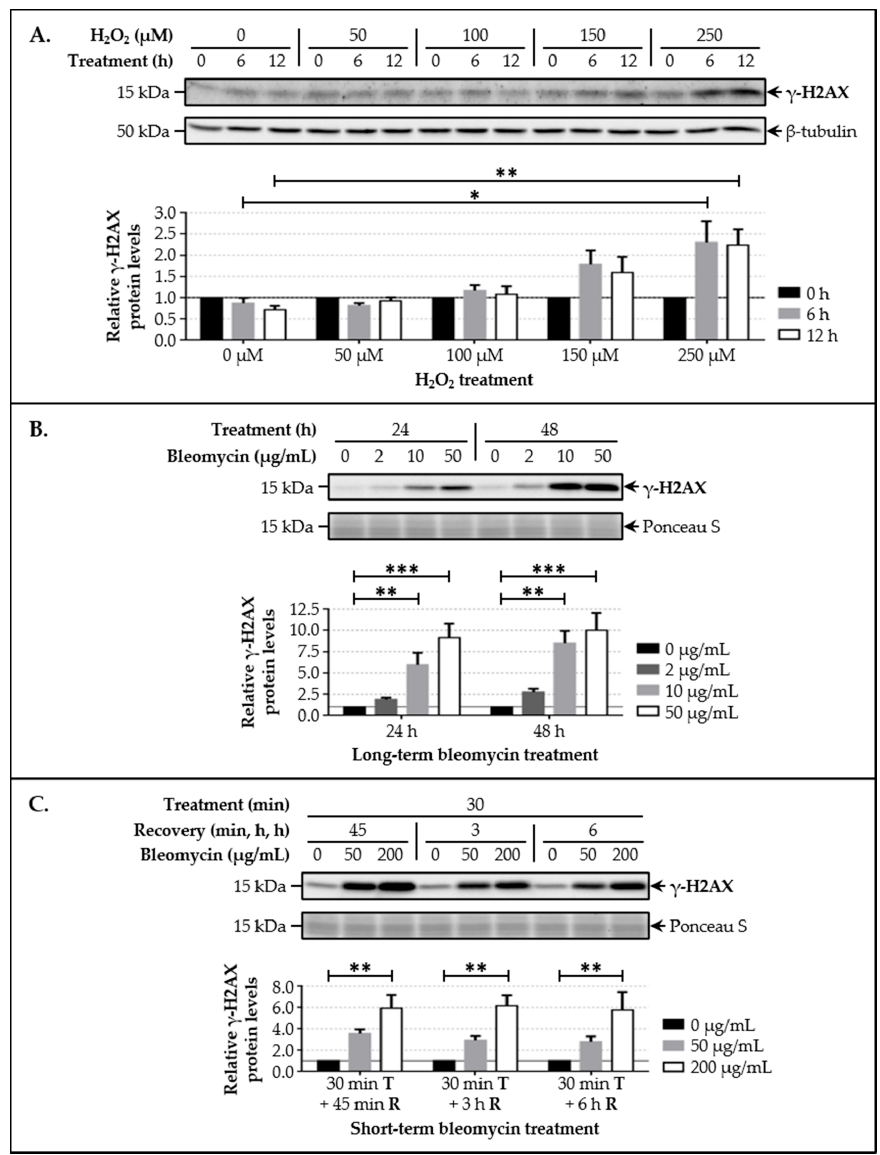
Figure 2. Detection of cellular DNA damage induced by H 2 O 2 and bleomycin treatments in the human HeLa cell line. ( A ) Relative γ -H2AX protein levels after cell exposure to 50, 100, 150 and 250 µM of H 2 O 2 for 6 h and 12 h (estimated in relation to untreated cells in the beginning of the experiment (0 h)). ( B ) Relative γ -H2AX protein levels after cell exposure to 2, 10 and 50 µg/mL of bleomycin for 24 h and 48 h (estimated in relation to untreated cells (0 µg/mL) at each timepoint). ( C ) Relative γ -H2AX protein levels after cell exposure to 50 and 200 µg/mL of bleomycin for 30 min (T), followed by 45 min, 3 h and 6 h of recovery (R) (estimated in relation to untreated cells (0 µg/mL) at each timepoint). In all treatments, HeLa cells’ whole lysates were analyzed by immunoblotting using a specific antibody against γ -H2AX to measure DNA damage levels. A representative blot is shown for each treatment. Quantitative data are presented as mean ± SEM ( n = 3 ( A , B ) or n = 4 ( C )). Before determining relative γ -H2AX protein levels, data normalization was performed using β -tubulin immunoblotting ( A ) or Ponceau S staining ( B , C ) as protein loading control. * p < 0.05, ** p < 0.01 and *** p < 0.001 for comparisons between control and treatment conditions using the Kruskal–Wallis test followed by the Dunn’s multiple comparison test. γ -H2AX, histone variant H2AX phosphorylated at Ser139; H 2 O 2 , hydrogen peroxide; SEM, standard error of the